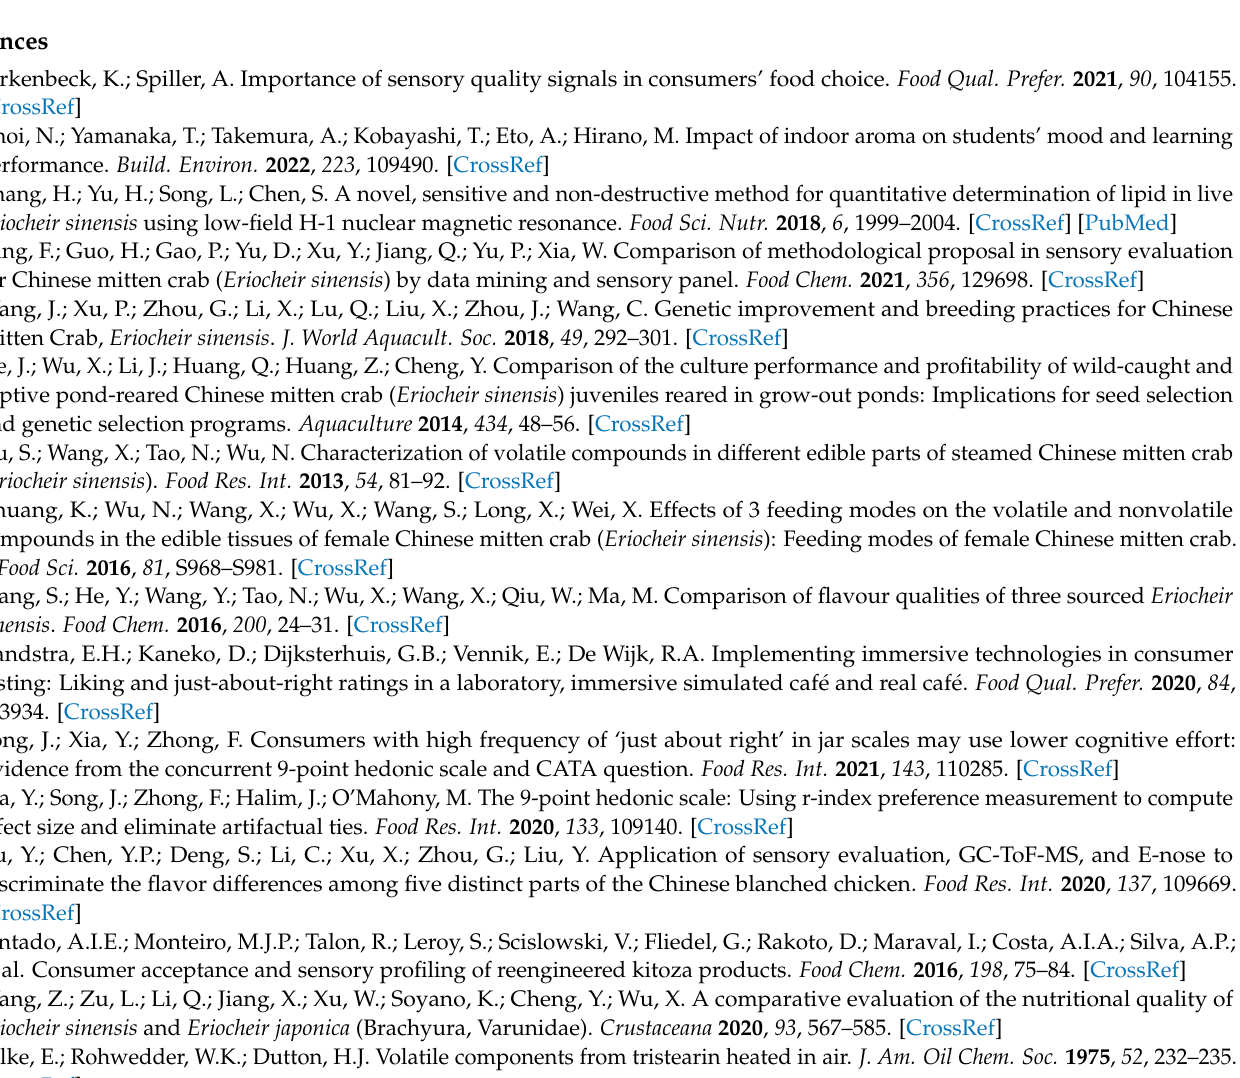
Table S3: The concentrations of volatile compounds were identified in the edible parts of E. sinensis from three areas ( µ g/kg, n = 3); Table S4: Active aromatic compounds (OAV > 10) in the edible parts of E. sinensis from three